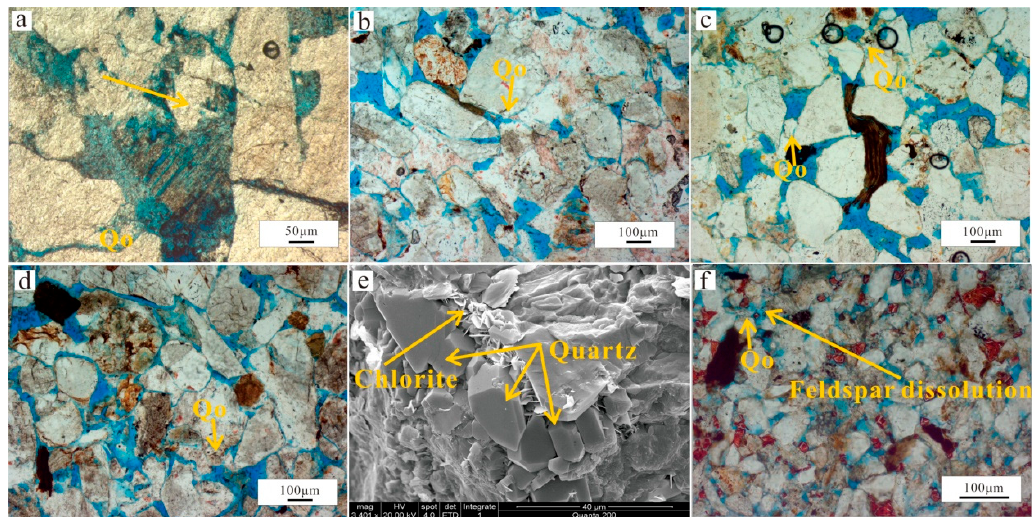
Figure 9. Photomicrographs showing characteristics of quartz cements. ( a )Authigenic quartz occurring as euhedral crystals partially infilling intergranular pores (yellow arrow), PPL. ( b ) Quartz overgrowths can be discriminated from the detrital grains due to the existence of dust rims, PPL. ( c ) Quartz overgrowths occluding the pore space, PPL. ( d ) Pores space engulfed by quartz syntaxial overgrowths, PPL. ( e ) Quartz overgrowths due to discontinuous chlorite. ( f ) Feldspar dissolution was accompanied by quartz overgrowths. Qo: Quartz overgrowths.